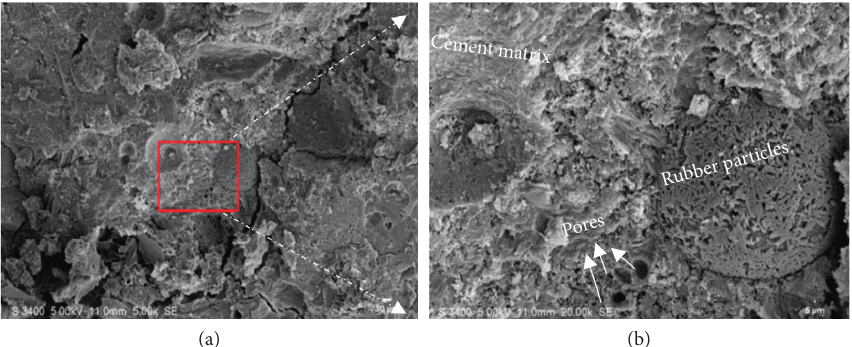
Figure 9: 0 freeze-thaw cycles. (a) SEM image of CRC. (b) Partially enlarged view of matrix cohesiveness.